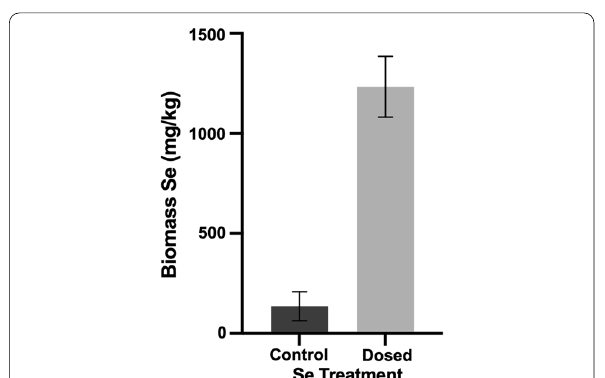
Fig. 5 Selenium biomass concentration for clonal propagated control plants and plants grown in soil spiked to 100 ppm Se with selenate and selenite at a ratio of 50:50. Two tailed t test showed a significant difference at P < 0.05 level. ( P